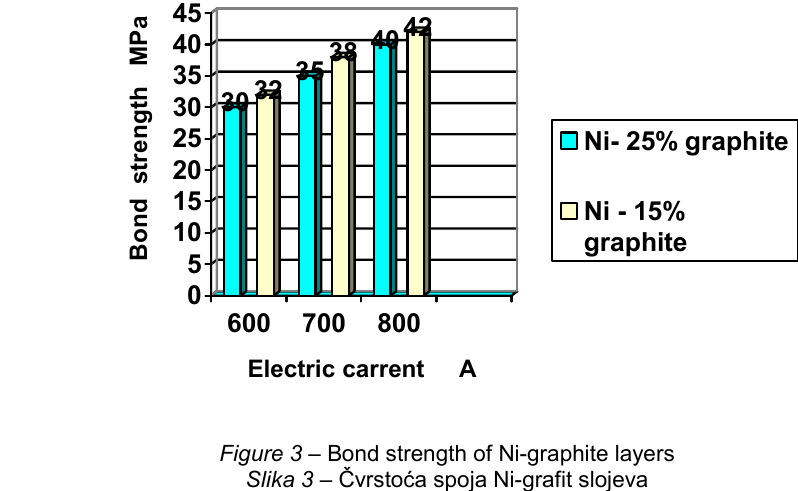
Figure 3 – Bond strength of Ni-graphite layers